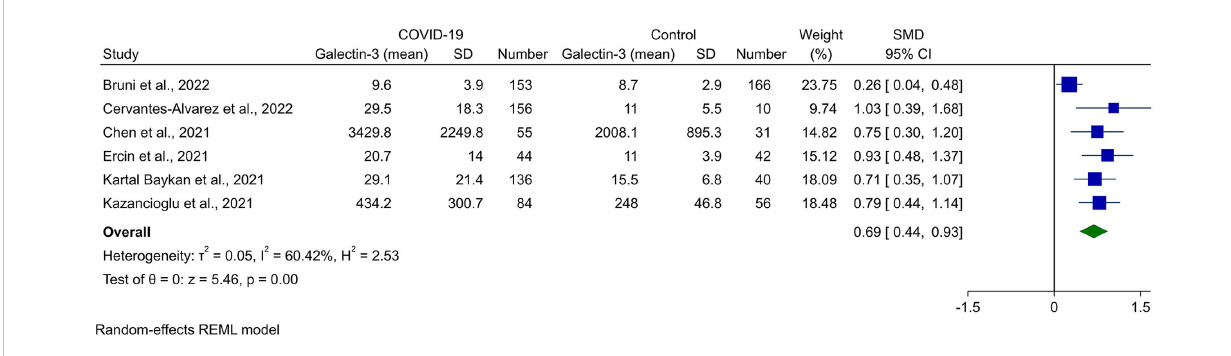
FIGURE 3 Forest plot for the meta-analysis of Gal-3 levels in COVID-19 patients vs. healthy controls after removing the outlier study (33).